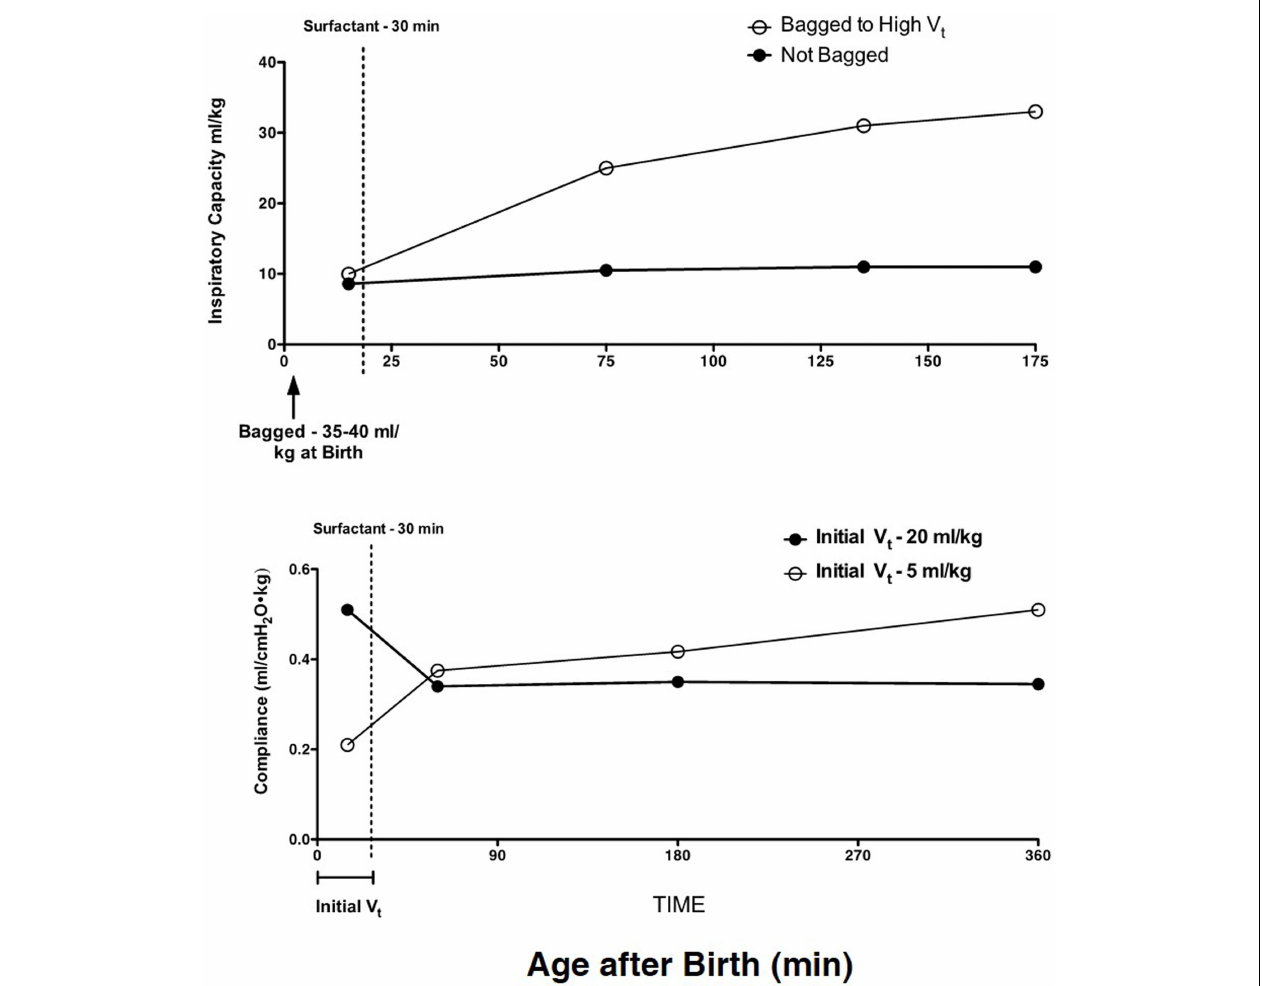
preterm lambs relative to a low tidal volume of 5ml/kg, but at 30min of age, the surfactant response is lost with the high tidal volume. The low tidal volume to 30min of age allows the lungs to respond to surfactant. Redrawn from data in Ref. (32).